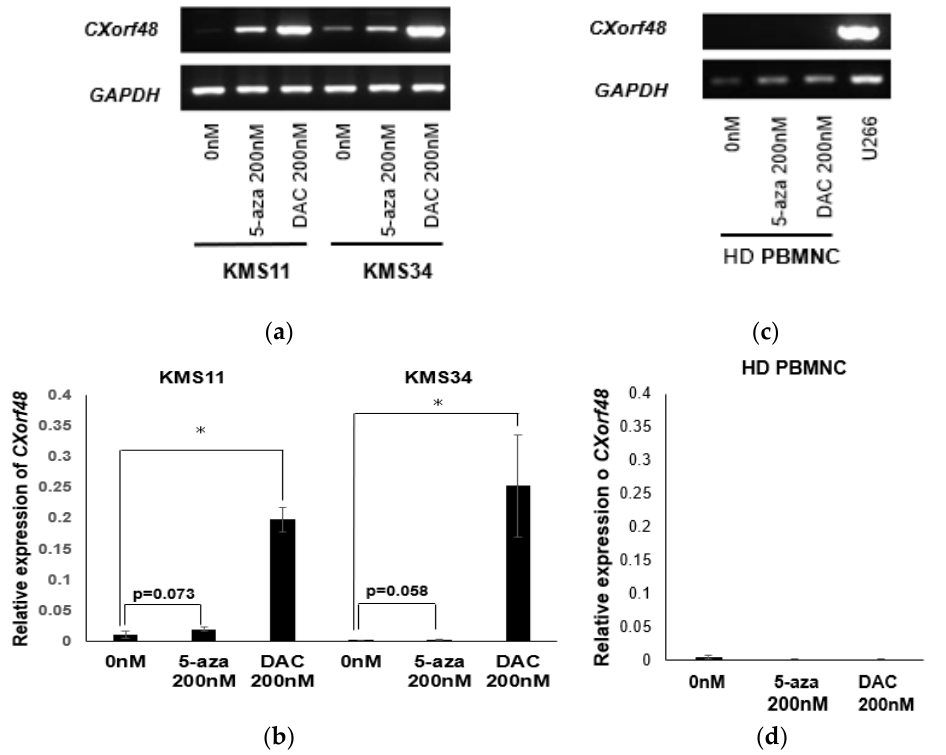
Figure 4. CXorf48 gene expression is up-regulated by treatment of demethylating agents. KMS11, KMS34, and peripheral blood mononuclear cells from healthy donor (HD PBMNC) were incubated with 200 nM of 5-azacytidine or 5-aza-2’-deoxycytidine for 72 h. RNA was extracted, and RT-PCR ( a , c ) or quantitative PCR ( b , d ) was performed. cDNA from U266 was used as a positive control for CXorf48 gene expression. Quantitative PCR was conducted in triplicate. Data are mean with standard deviations. * p < 0.05 (Student’s t -test).